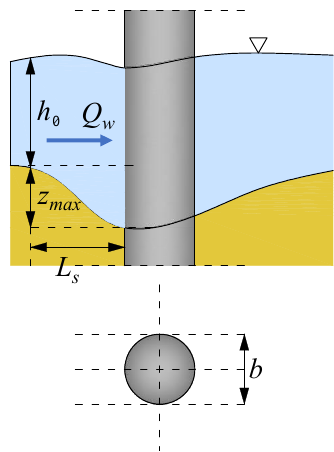
Figure 4. Pier model and scour parameters: h 0 —water depth, z max —maximal scour depth, Q w —water discharge, b —pier diameter, L s —upstream scour length.